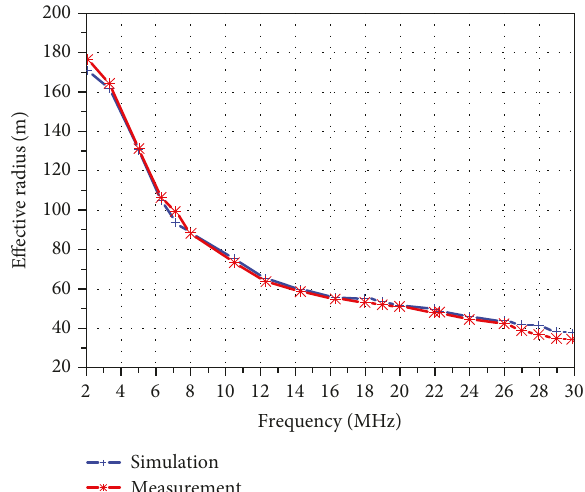
Figure 11: The variation curve of the e ff ective radius with frequency in the measurement.